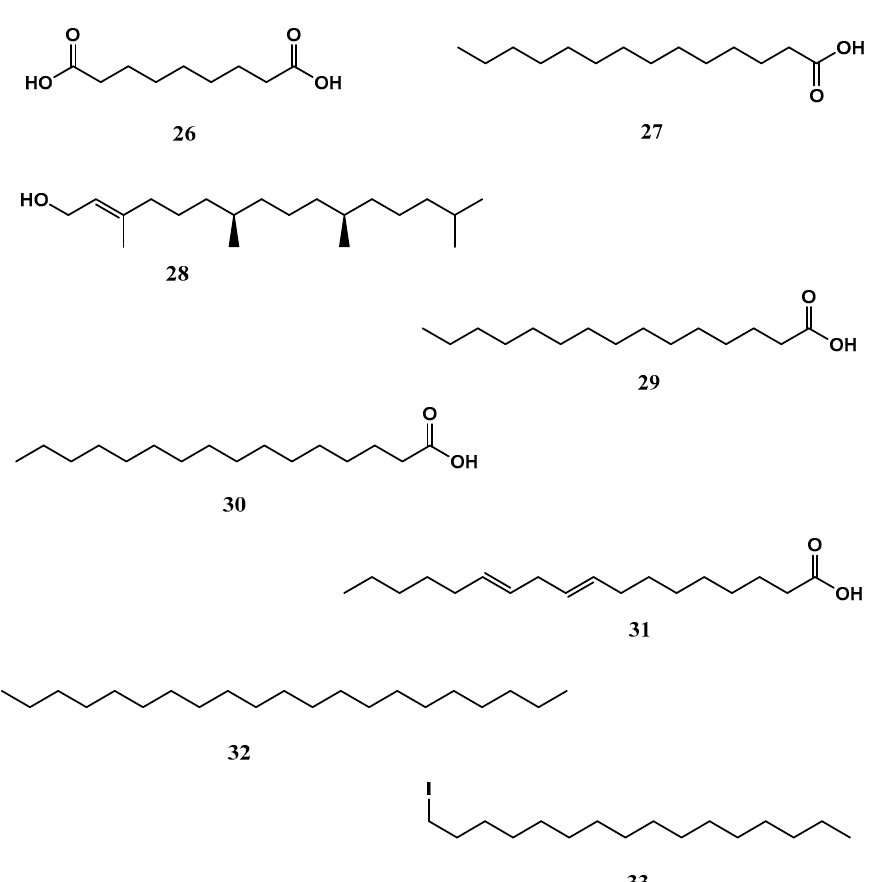
Figure 7. The chemical structures of long-chained fatty acids from Xestospongia testudinaria ( 26 - 33 ). The above studies indicated that potential secondary metabolites were found in X.